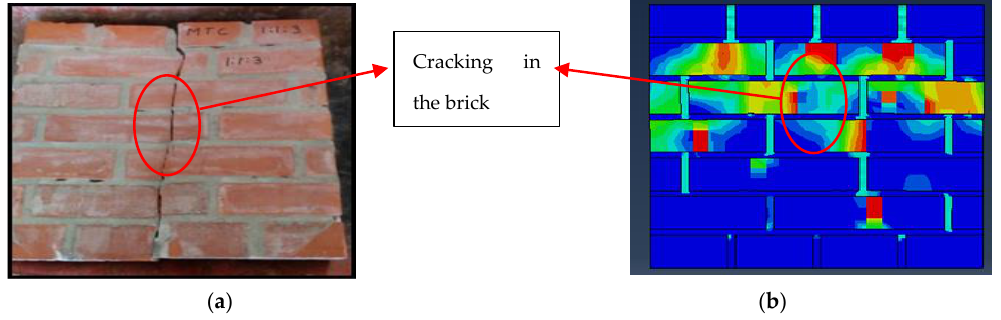
Figure 15. ( a ) Experimental crack pattern; ( b ) numerical crack pattern of unreinforced wall (MCB).